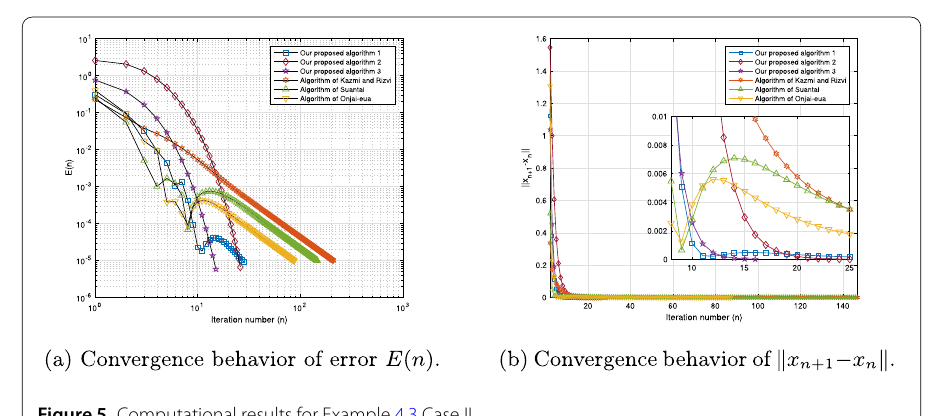
Figure 5 Computational results for Example 4.3 Case II